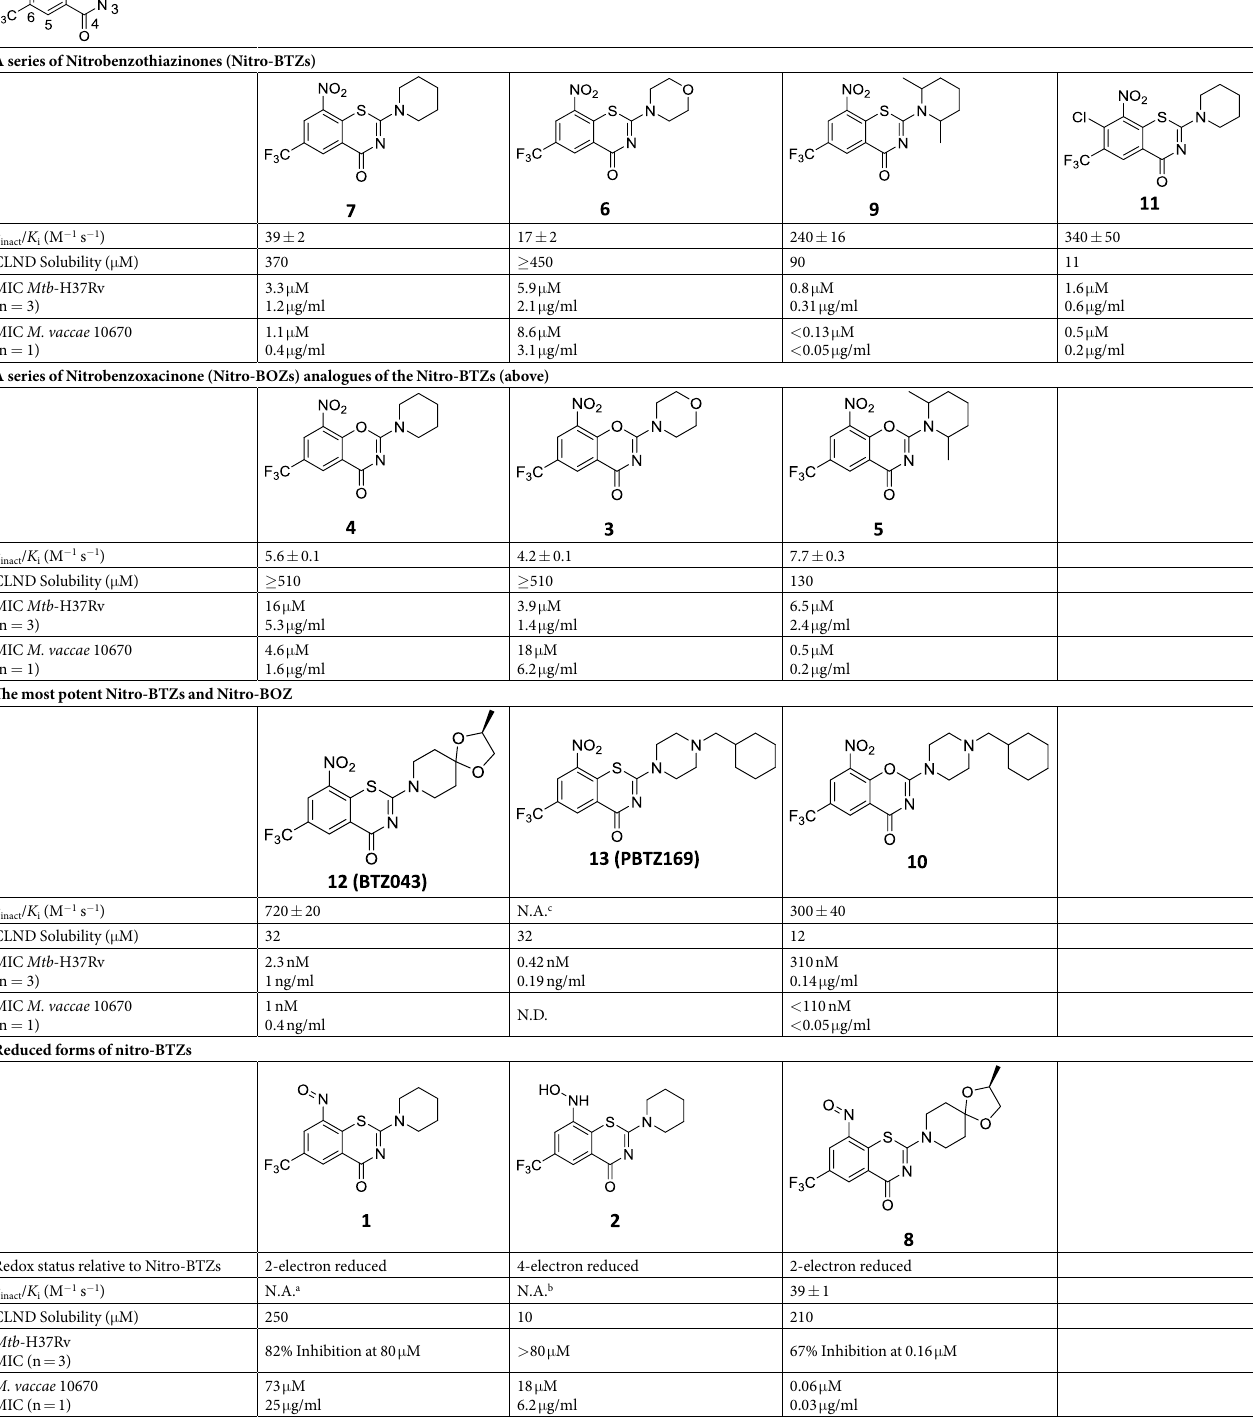
Table 1. Correlation between the kinetics of inactivation of Mtb-DprE1 with cellular potency by BTZs and BOZs. a k inact / K i value for 1 could not be obtained because the time-courses only mildly deviate from linearity in the first 100 min of reaction making fitting to Eq. 1 difficult; the IC 50 decreases from 5 to 3 μ M during the first 100 min of reaction (see Fig. S1A). b k inact / K i value for 2 could not be obtained because the k obs versus inhibitor concentration relationship was concave up; the IC 50 decreases from 3.5 to 0.8 μ M during the first 100 min of reaction. c k inact / K i value for 13 could not be obtained using the present assay due to tight-binding limit considerations 19 ; the 10–170 nM inhibitor concentration range where inhibition is observed is less than or equal to the concentration of DprE1 in the assay resulting in inhibitor depletion over time (see Fig.